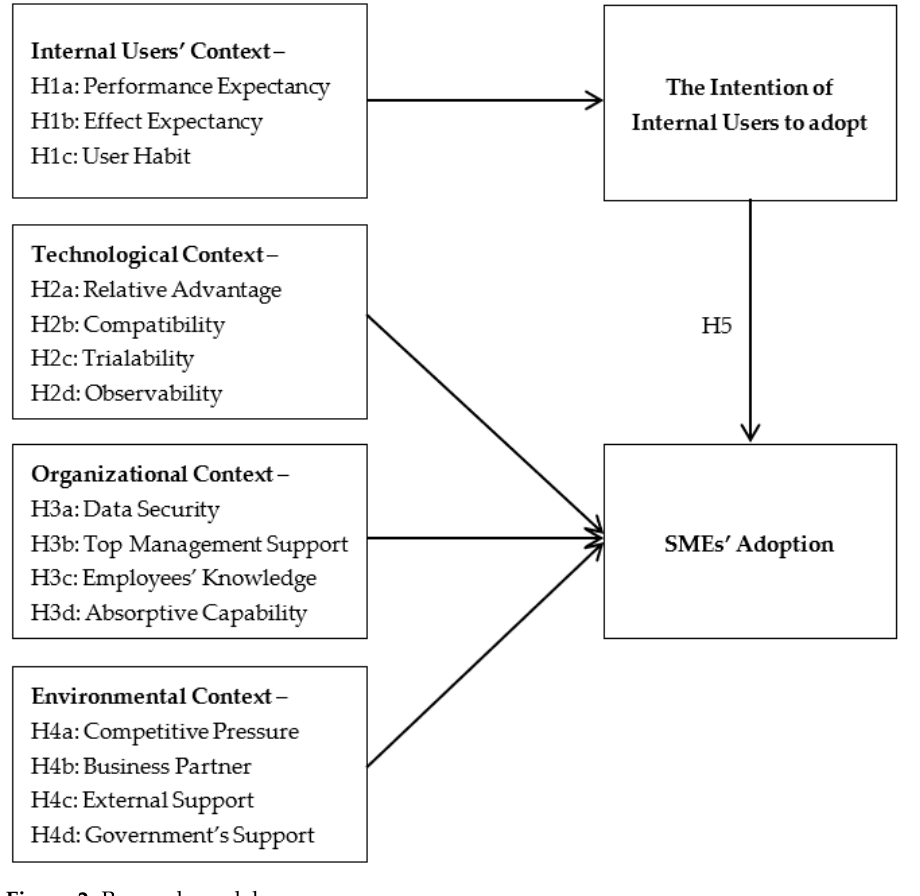
Figure 2. Research